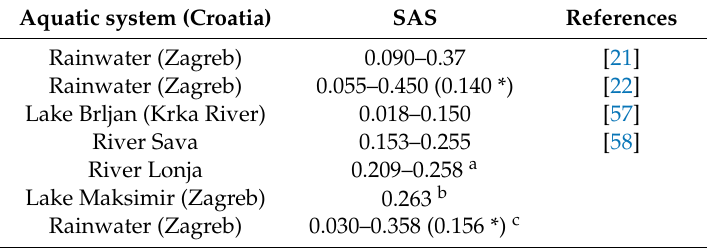
Table 2. Concentration of SAS (mg L − 1 eq. Triton-X-100) in surface and rainwaters in Croatia. Aquatic system (Croatia)